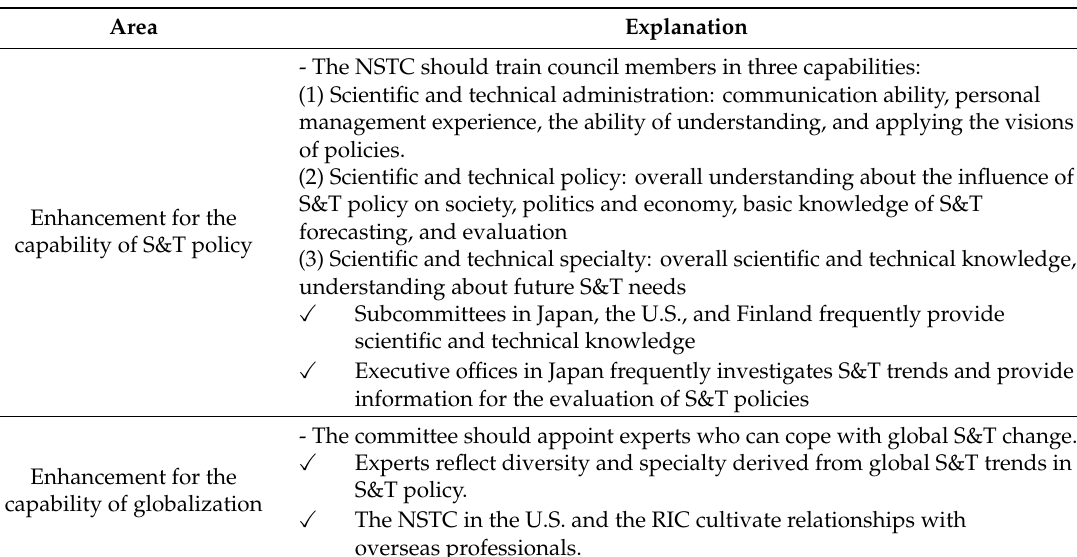
Table 8. Basic directions for enhancement of human resource management.